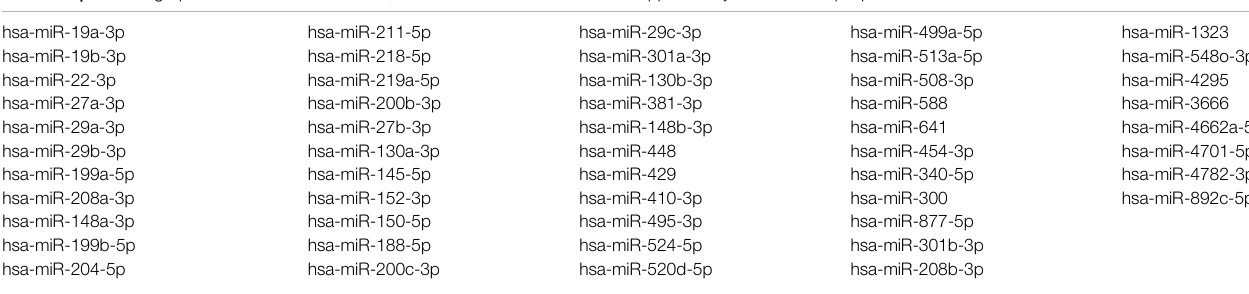
TABLE 2 | Predicting upstream miRNAs of CCNA2, and these miRNAs have been supported by the CLIP-Seq experiment.